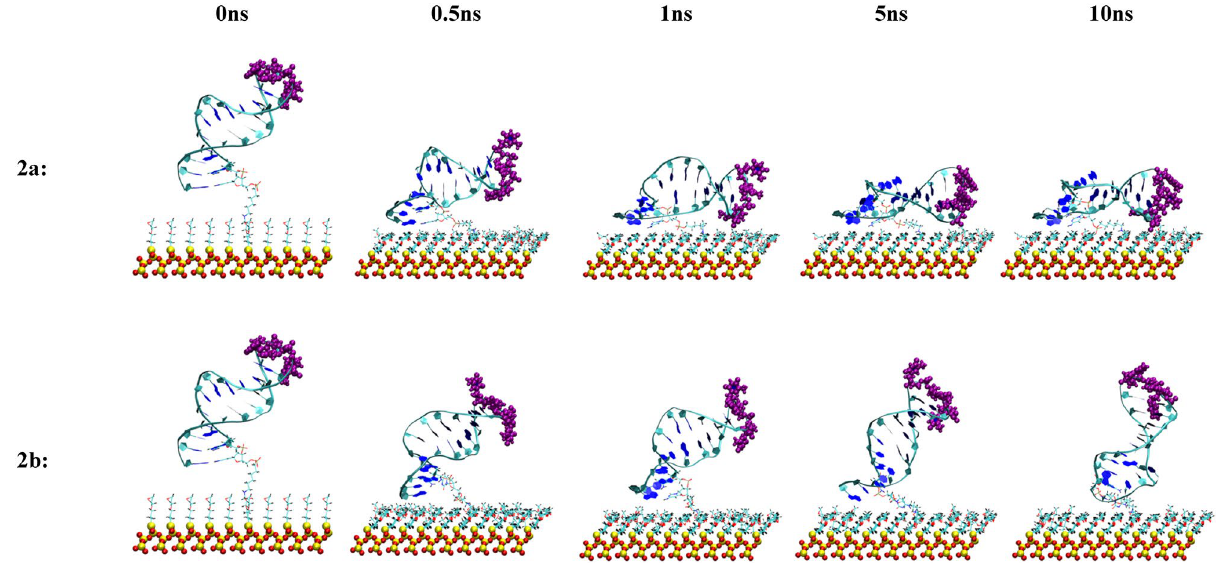
Figure 9. Snapshots of the MD simulation of the anti MUC1 aptamer tethered to the SiO 2 biosensor substrate in configuration 2 (5 ′ end attachment, perpendicular to surface, low density) neutralized (top) and in 0.8 M (bottom) solution concentrations at 0 ns, 0.5 ns, 1 ns, 5 ns, and 10 ns. The MUC1 binding residues (thymine residues 11 and 13) are displayed in purple.